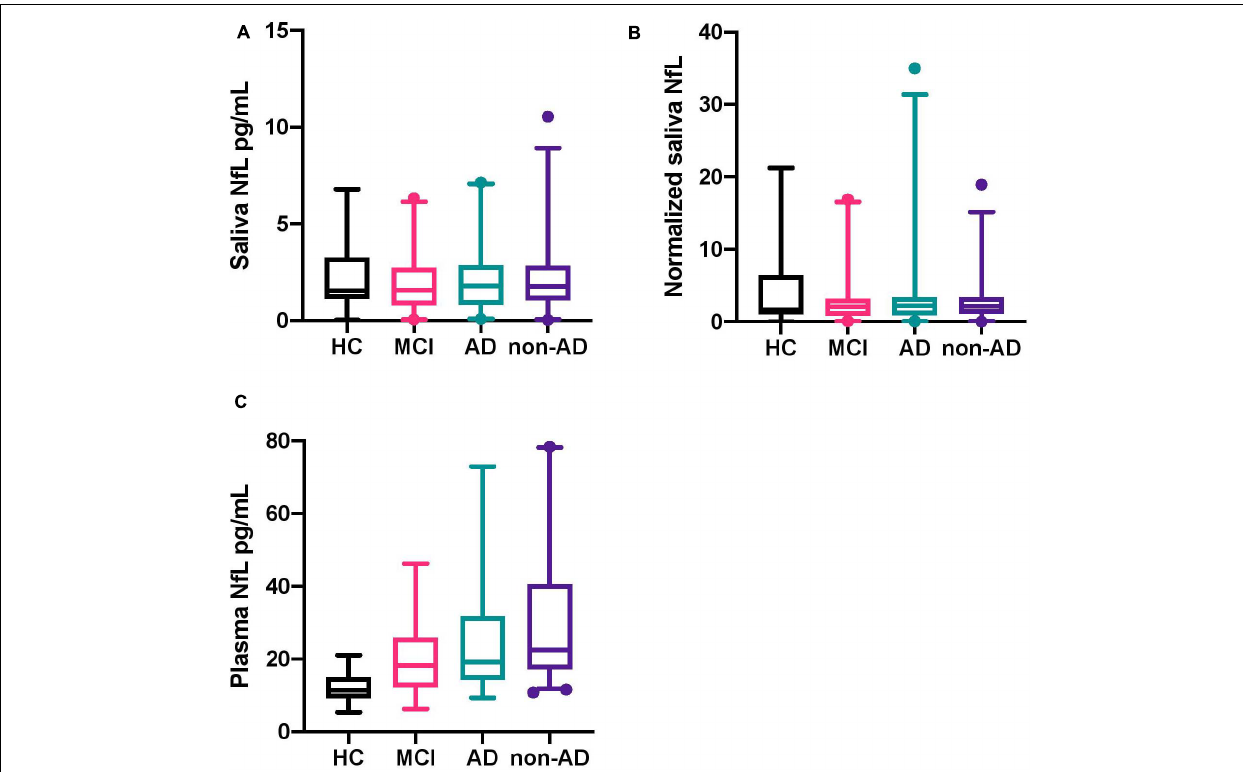
FIGURE 1 | Box plots of neurofilament light chain levels in saliva and plasma and the normalized levels of saliva NfL. (A) The boxplots show the median, interquartile range, and the extreme values of salivary NfL for HC, MCI, AD, and non-AD. The 2.5–97.5 percentile of all data had been included in the boxplots. (B) The boxplots show the median, interquartile range, and the extreme values of the normalized levels of salivary NfL for HC, MCI, AD, and non-AD. The 2.5–97.5 percentile of all data had been included in the boxplots. (C) The boxplots show the median, interquartile range, and the extreme values of plasma NfL for HC, MCI, AD, and non-AD. The 2.5–97.5 percentile of all data had been included in the boxplots. NfL, neurofilament light chain; HC, healthy controls; MCI, mild cognitive impairment; AD, Alzheimer’s disease.